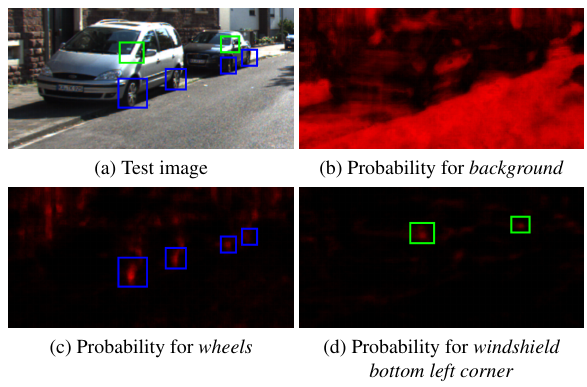
Figure 3. Examples for the output of the keypoint classifier. Brighter red denotes higher